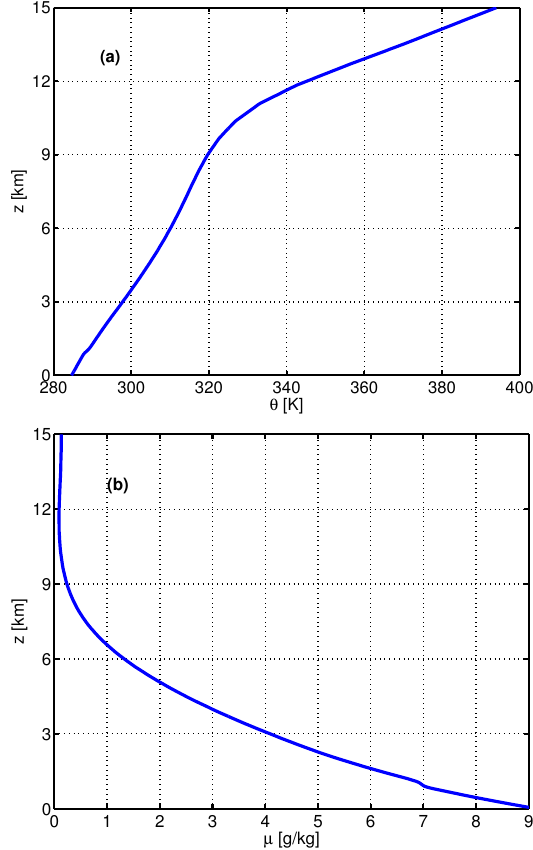
Fig. 2. (a) Initial potential temperature profile computed by aver- aging an 18yr-long ECMWF ERA-Interim reanalysis data series for the coordinates 47.25 ◦ N, 7.875 ◦ E (Swiss Plateau), represent- ing typical midlatitude atmospheric conditions. (b) Initial moisture profile corresponding to 100% RH (to foster precipitation) based on the potential temperature profile in (a)